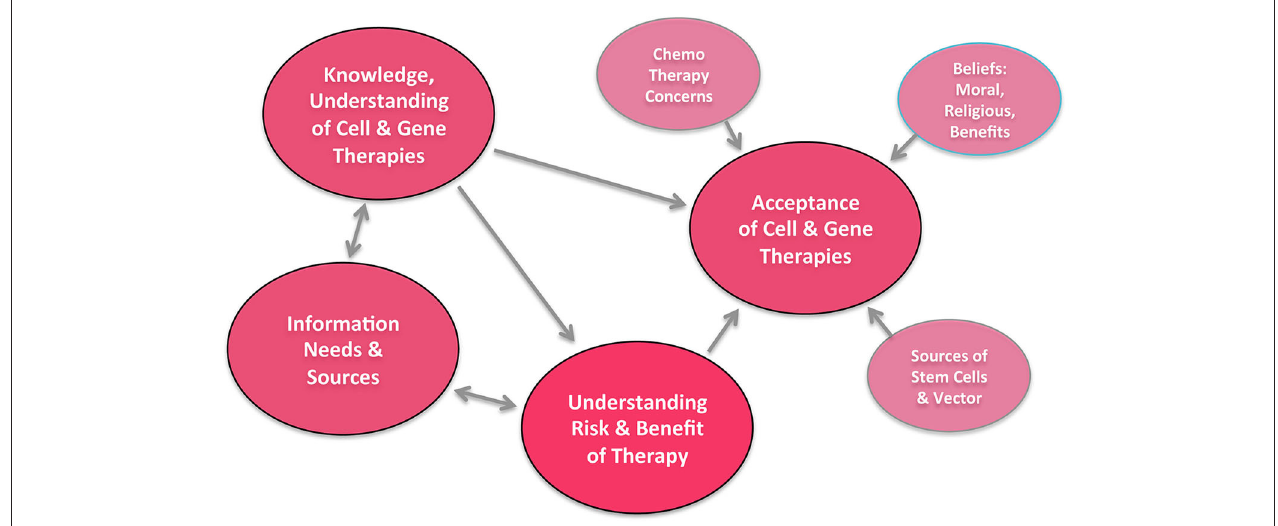
FIGURE 5 | Relationship between various themes and how they affect overall acceptance of cell and gene therapies, adapted from Aiyegbusi et al. (21). In our “ATMP EU Survey,” the highlighted four main groups (emphasized larger circles) were found to be of key